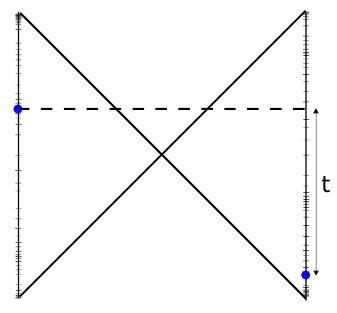
Figure 8 . Two-point correlator in a thermodouble system. The saddle is the black hole solution, whose Penrose diagram is drawn. One can readily compute correlators on opposite sides of the wormhole. The Schwarzian path integral contains time reparametrizations of the boundary lines that are constrained to start and end at the same points as the eternal black hole time coordinate. A sample clock-ticking con(cid:12)guration is